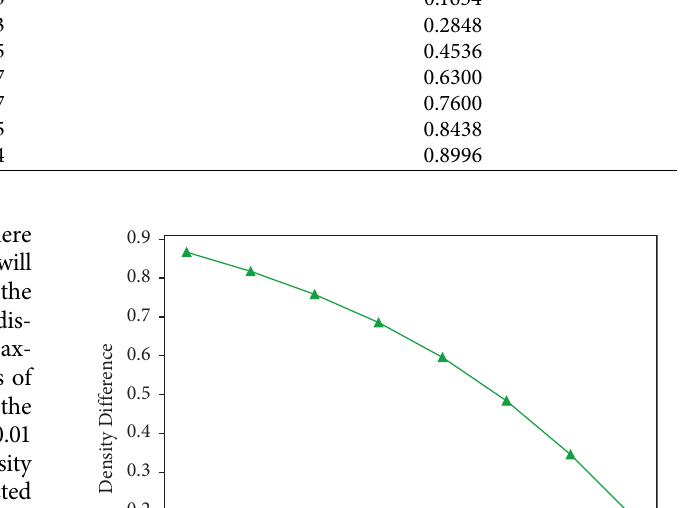
Table 4: Comparison of the maximum propagation range achieved by the traditional model and the model node O of this paper. Initially the density of node O Maximum density of node O in traditional model The maximum density of node O in our model 0.01 0.3147 0.0360